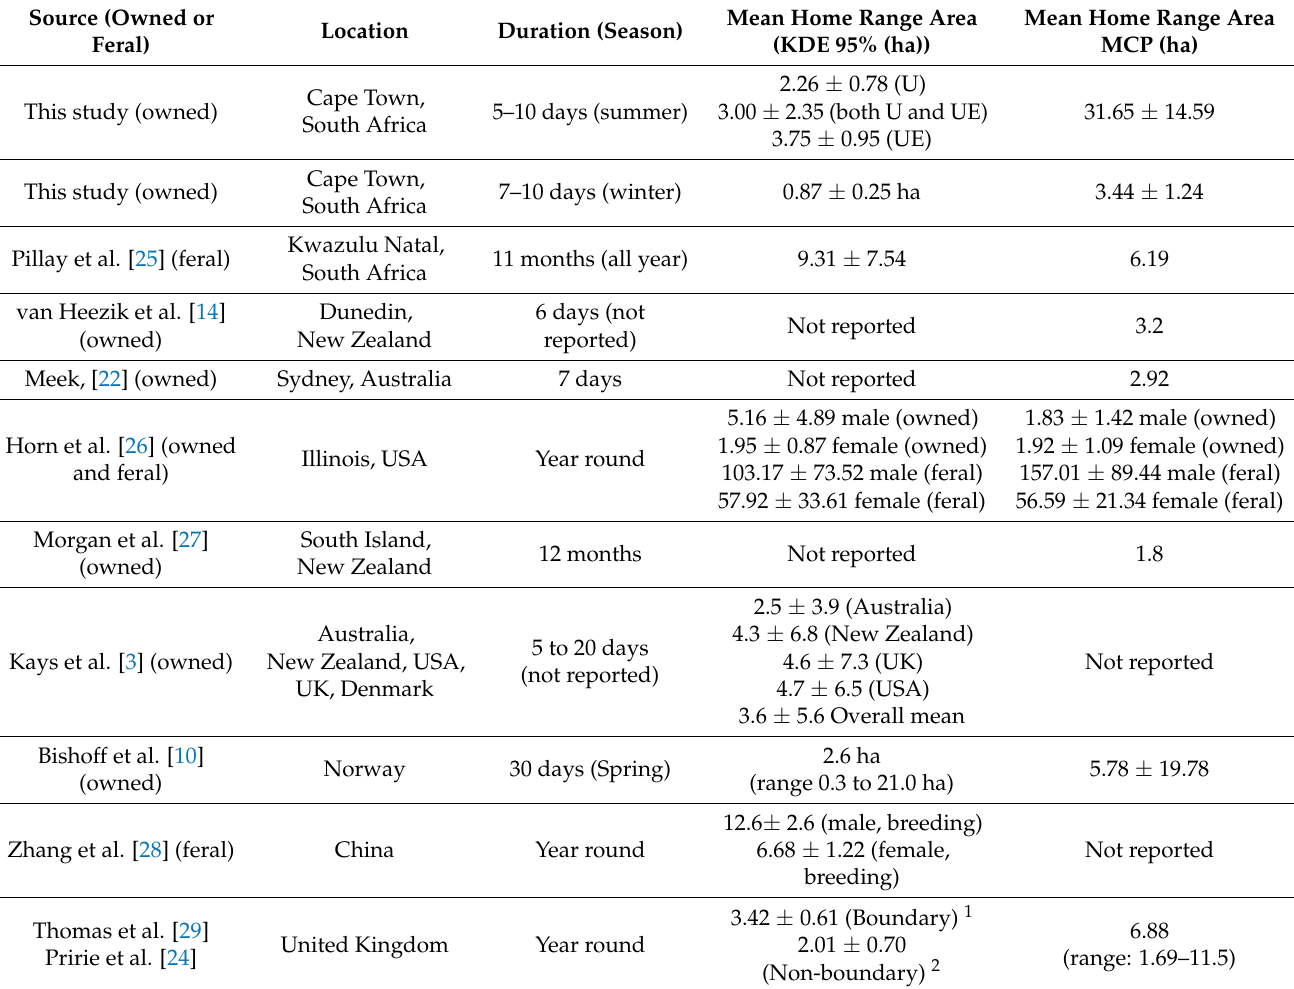
Table 1. Comparison of the mean home range area (95% kernel density estimates, KDE) of adult free-roaming domestic cats (owned and feral) across published studies. Early studies only reported maximum convex polygon (MCP) as a measure of home range, so we have also included that metric. Urban (U: > 150 m from the urban-edge) and urban-edge (UE: < 150 m from the urban-edge) cats are distinguished in our study and that of Pririe et al. [24], who used different distances (1000 m) for Non-Boundary vs. Boundary